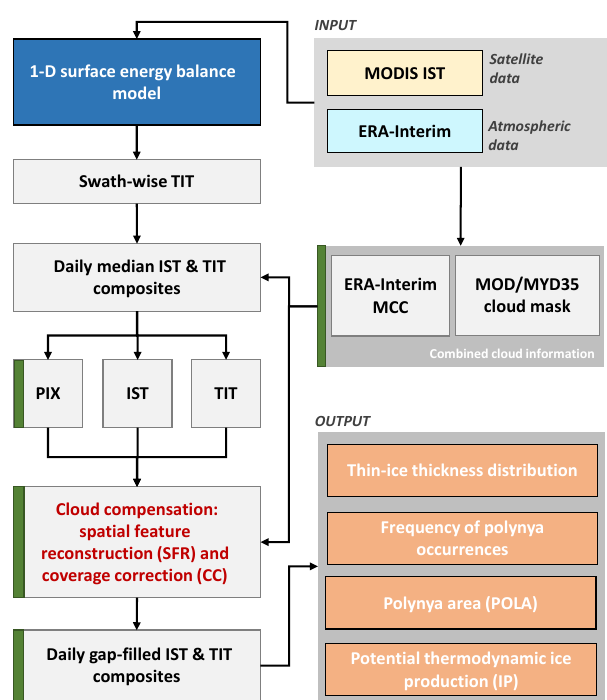
Figure 2. Schematic overview on the current version of the MODIS thin-ice thickness (TIT) retrieval scheme based on Paul et al. (2015b) and Preußer et al. (2015a). The most recent updates are marked in green and are mainly aimed towards an additional cloud- cover treatment. Aside from indicated abbreviations, “IST”, “MCC” and “PIX” denote the ice-surface temperature, medium cloud cover and persistence index,